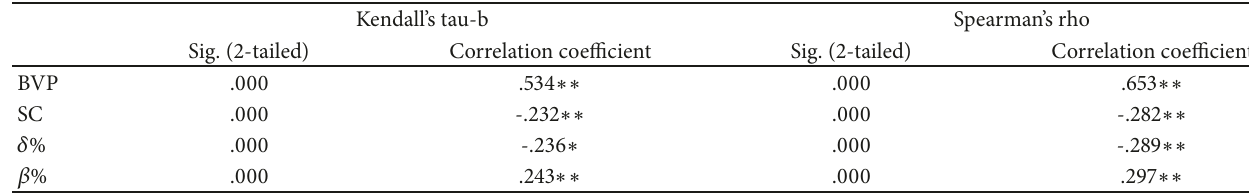
Table 5: The correlations between bio-signals, brain signals and anger